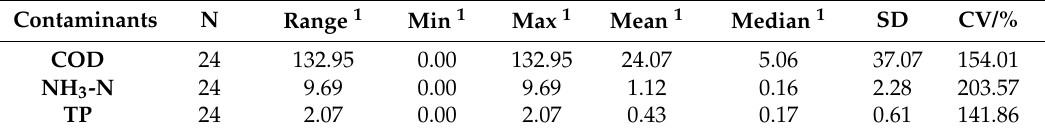
Table 3. Descriptive statistics of reduced WEC of contaminants in 24 sub-basins during the dry season. Contaminants N Range 1 Min 1 Max 1